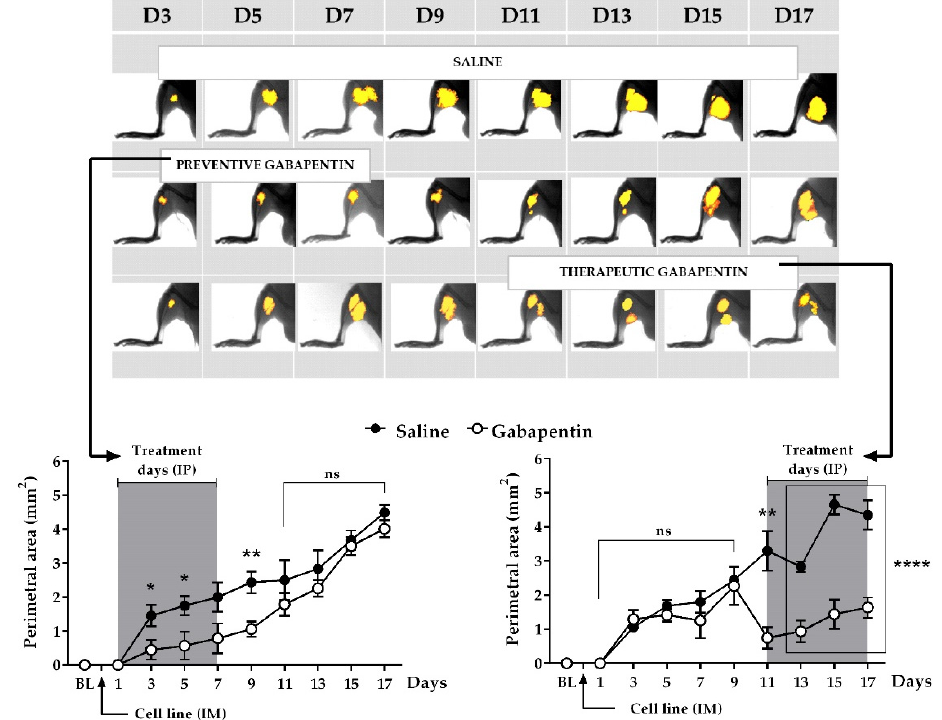
Figure 4. Tumor progression: Above : Representative image sequences, obtained with in vivo imaging techniques, 12 h after gabapentin administration, indicating tumor progression in three different intact mice receiving either IP saline (first row), preventive IP gabapentin (second row), or therapeutic IP gabapentin (third row) after the inoculation of the cell line. Below : Perimetral area (mm 2 ), corresponding to all tumors growing in animals receiving either saline or gabapentin (100 mg/Kg). Left : Preventive treatment. Right : Therapeutic treatment. BL: Baseline (response value before IM inoculation of the cell line and before starting treatment). ns: non-significant. * p ≤ 0.0314, ** p ≤ 0.0024, **** p ≤ 0.0001, n = 10 mice/group. Each point represents the mean ± SEM of the sample.